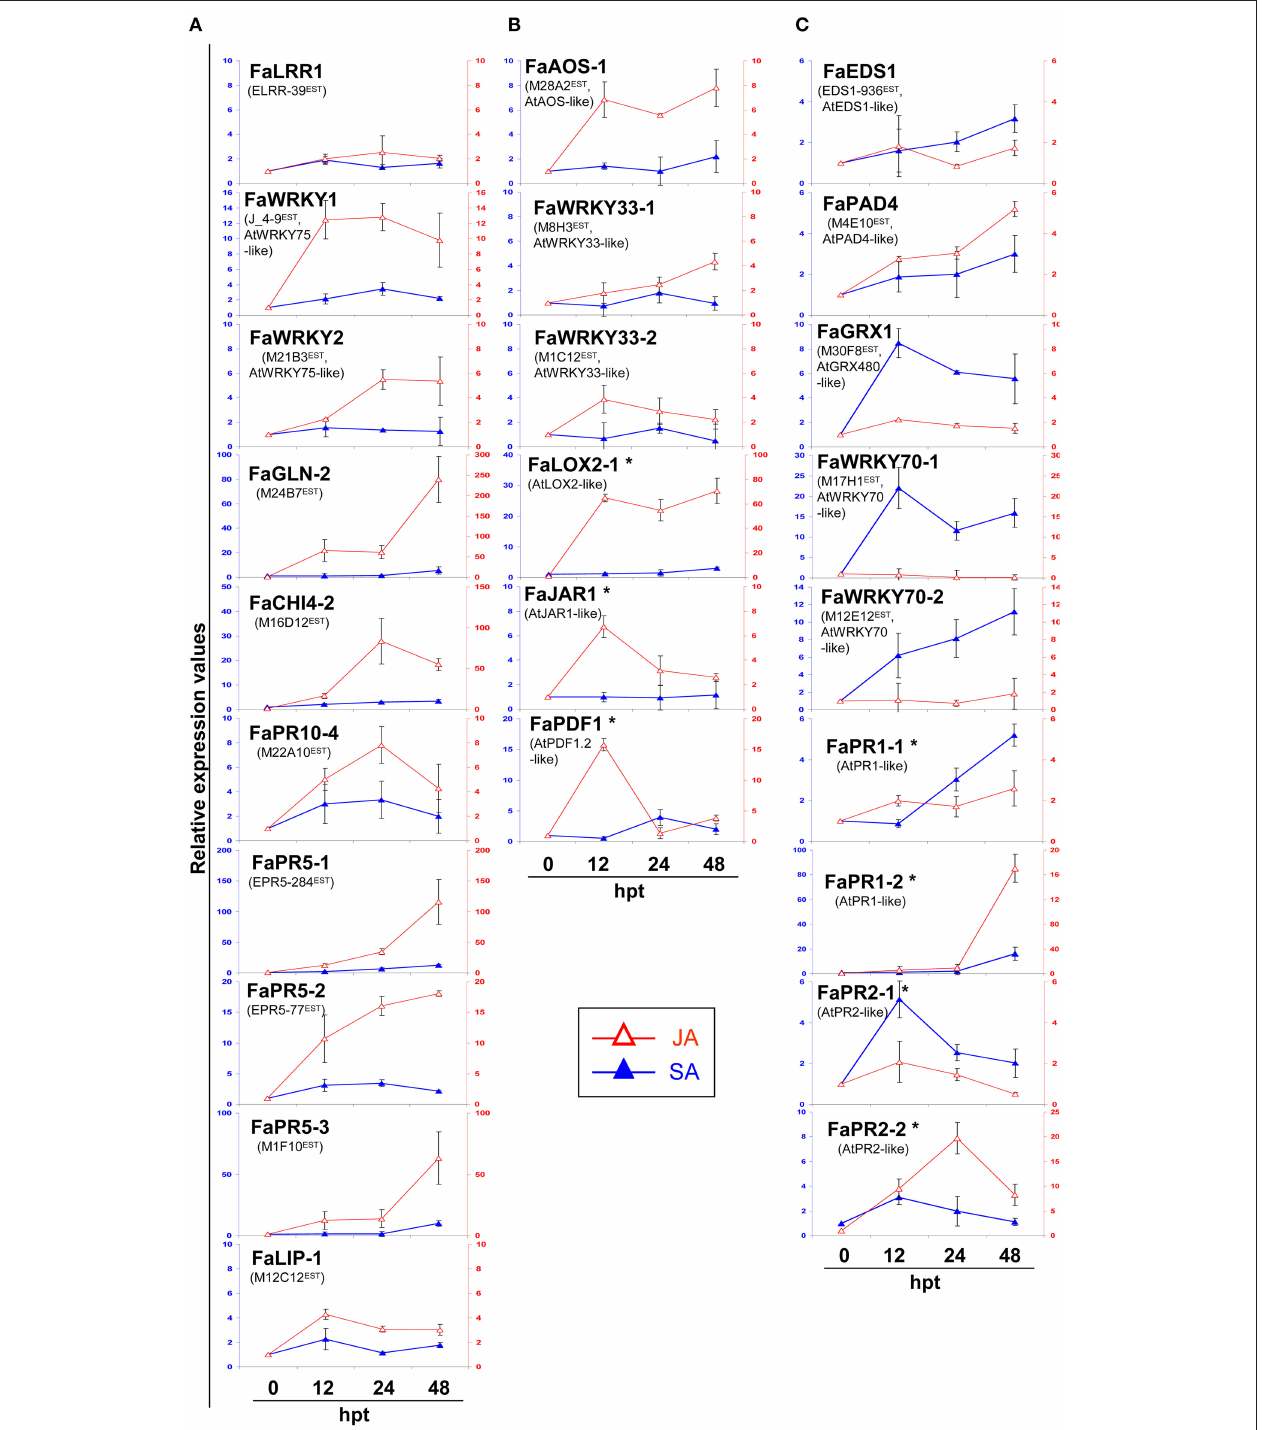
FIGURE 6 | Relative expression values by RTqPCR analysis of upregulated strawberry genes by hormone treatment. (A) Relevant strawberry genes in this study, (B) JA-responsive marker genes, and (C) SA-responsive marker genes. Strawberry plantlets were treated with mock, SA (5 mM) and MeJA (2 mM) elicitors, and harvested at different hours post-treatment (htp). At each time point, every elicited sample was compared against its corresponding mock treated sample. Left and right legends represent relative expression values for SA and JA treatments, respectively. In the graphics, standard value 1 at T0 was added to better illustrate changes. Asterisk marks genes not present in the Array dataset. Arabidopsis orthologous are AT5G13080 ( AtWRKY75 ), AT5G42650 ( AtAOS ), AT2G38470 ( AtWRKY33 ), AT3G45140 ( AtLOX2 ), AT2G46370 ( AtJAR1 ), AT5G44420 ( AtPDF1.2 ), AT3G48090 ( AtEDS1 ), AT3G52430 ( AtPAD4 ), AT1G28480 ( AtGRX480 ), AT3G56400 ( AtWRKY70 ), AT2G14610 ( AtPR1 ), AT3G57260 ( AtPR2 ).